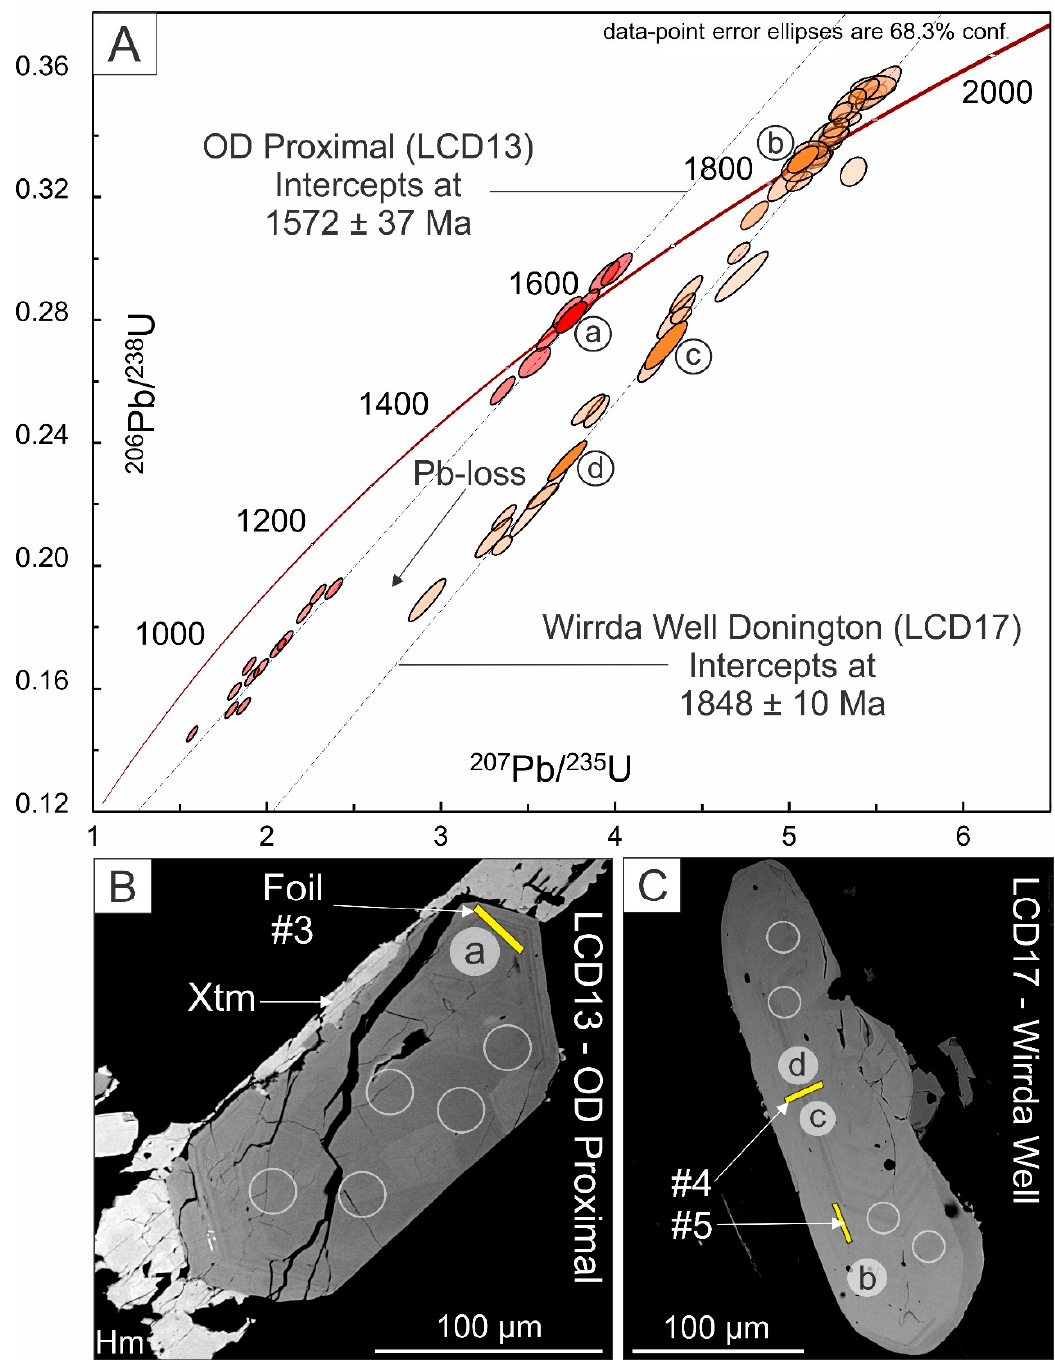
Figure 3. Concordia diagram ( A ) for OD proximal zircon (LCD13, red ellipses) and Wirrda Well zircon (LCD17, orange ellipses; U–Pb data are presented in Supplementary Materials B, Table S3). Circled letters correspond to LA-ICP-MS craters in BSE images of the dated grains ( B and C ).